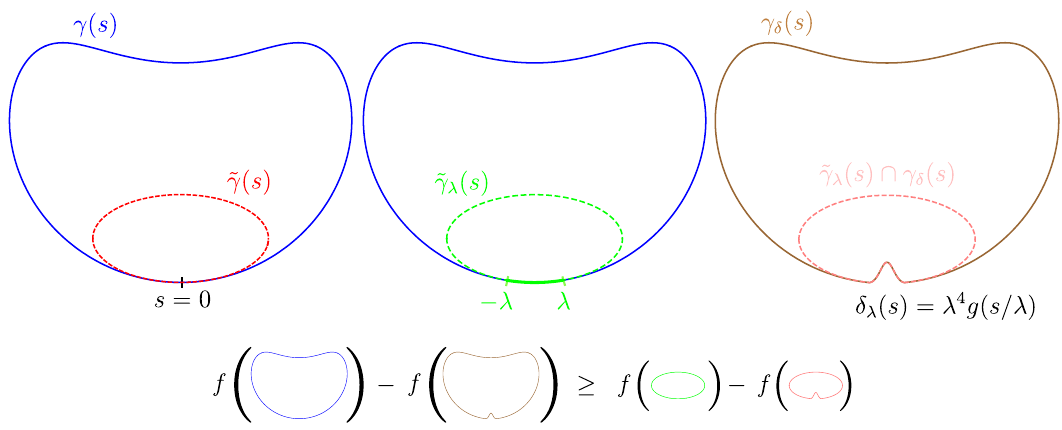
Figure 8 . We show an schematic representation of the geometric setup leading to the inequal- ity (5.16). In the left plot we show two entangling regions, ˜ γ ( s ) ⊆ γ ( s ) such that ˜ γ ( s ) is osculating to γ ( s ) at s = 0 . The second plot includes γ ( s ) and a deformed version of the inner region, ˜ γ λ ( s ) , which exactly coincides with γ ( s ) for s ∈ ( − λ, λ ) . The third plot shows deformed versions of γ ( s ) and ˜ γ λ ( s ) which include a small inwards bump supported within the interval for which both regions coincide. The equation shown below is just (5.15) in the particular case considered